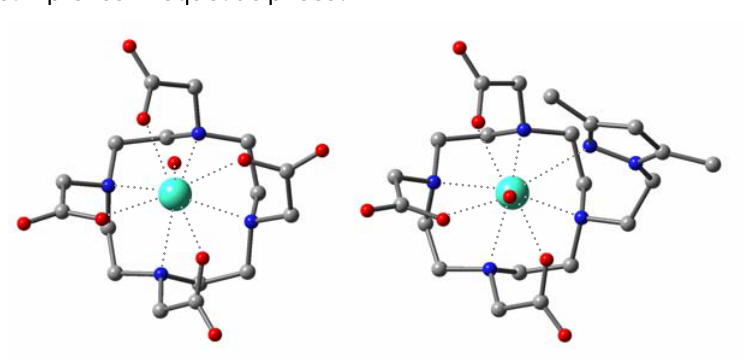
Optimized geometries for the Gd(III)-dota (left) and Gd(III)-2 (right) complexes in aqueous phase.